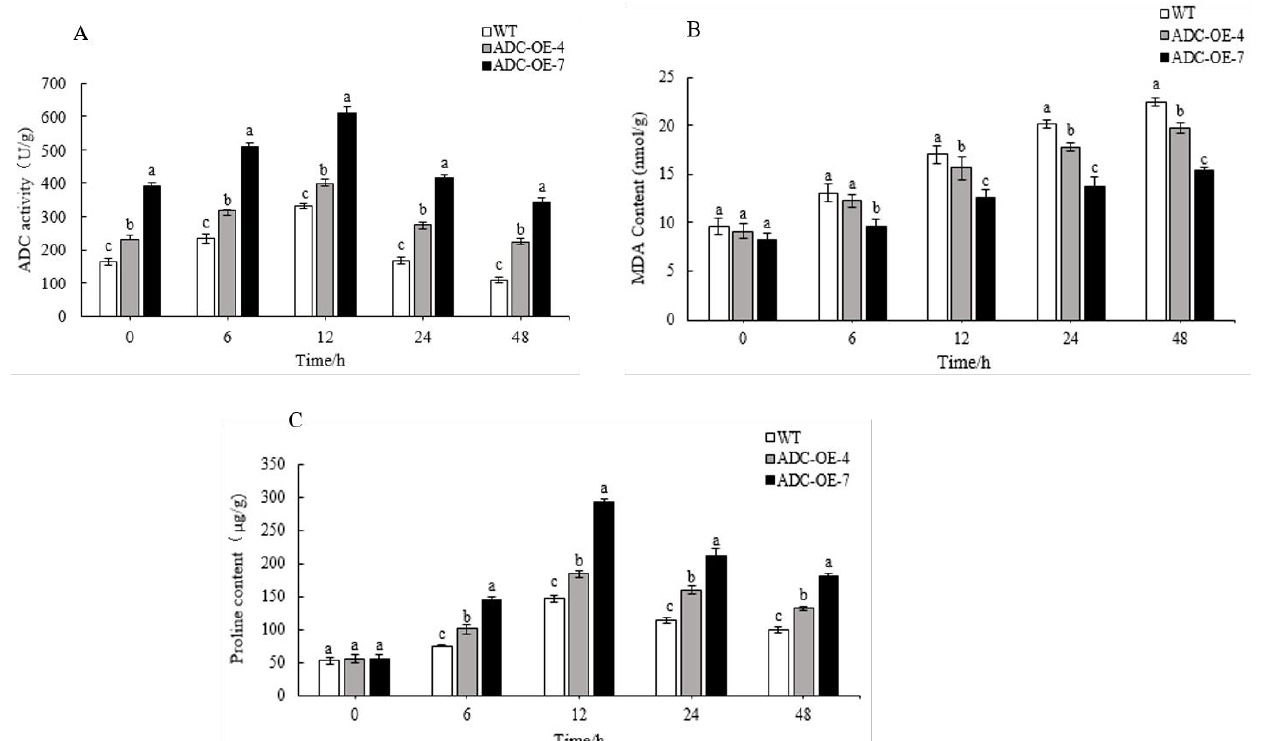
Figure 4. Determination of physiological parameters of transgenic lines and WT. ( A ) ADC activity in WT, CpADC -OE-4 and CpADC -OE-7. ( B ) MDA contents in WT, CpADC -OE-4 and CpADC -OE-7. ( C ) Proline content in WT, CpADC -OE-4 and CpADC -OE-7. Note: Different lowercase letters are used to indicate means that differ significantly ( p ≤ 0.05).